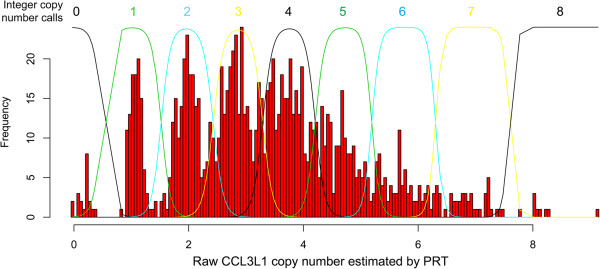
Calling integer CCL3L1 copy number from raw PRT data. The histogram shows the copy number distribution of 1133 individuals. A Gaussian mixture model, with seven components, is fitted to the data, and each individual component is plotted with the corresponding integer copy number shown above each peak.